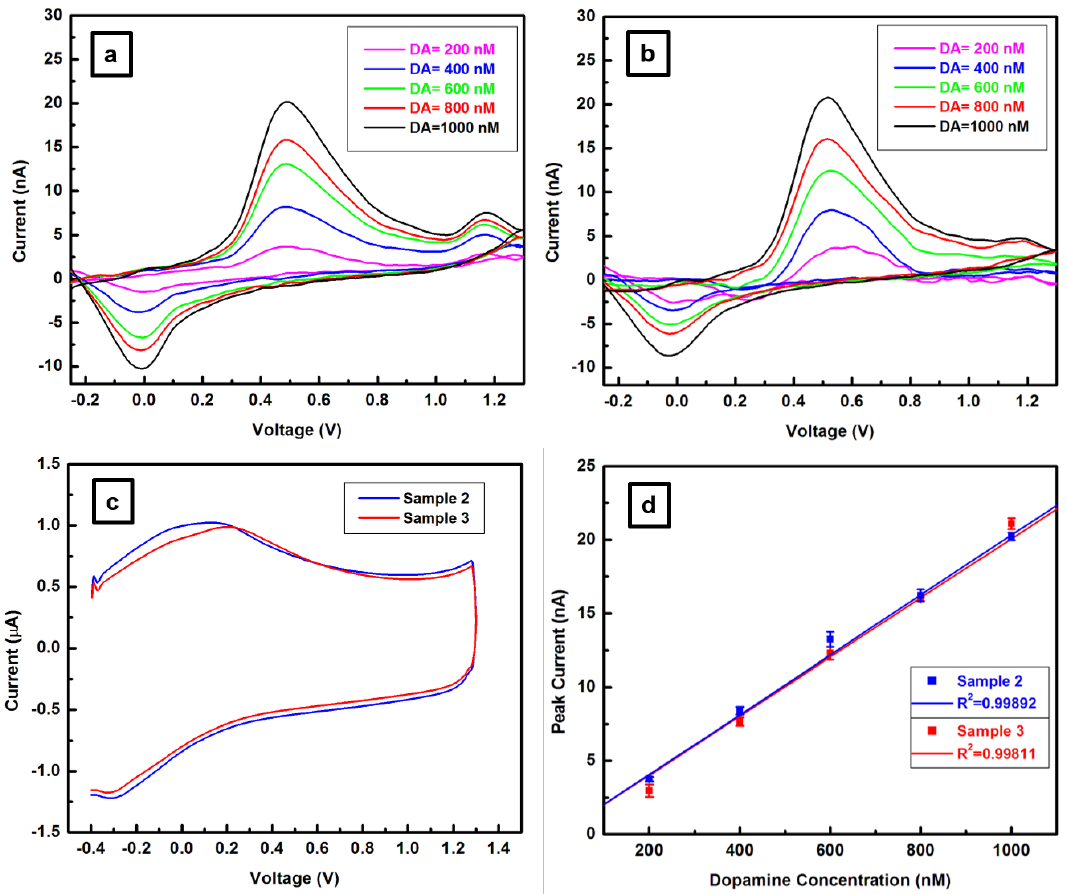
Figure 5. ( a , b ) Cyclic voltammograms at 200, 400, 600, 800 and 1000 nM dopamine (DA) for carbon fiber microelectrodes (CFMs) fabricated from samples 2 and 3 CFs, respectively, as labeled. ( c ) Shape and amplitude of the background current for the CFMs associated with ( a , b ). ( d ) Average detected oxidation peak current showing a linear increase for both CFMs, with a correlation coefficient of about 1.0 based upon three trials at each DA concentration.